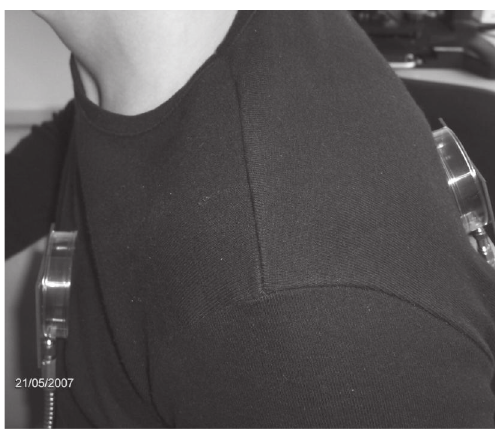
Figure 11: Setup for the channel-loss measurement, setup between the front and the back of a human chest.